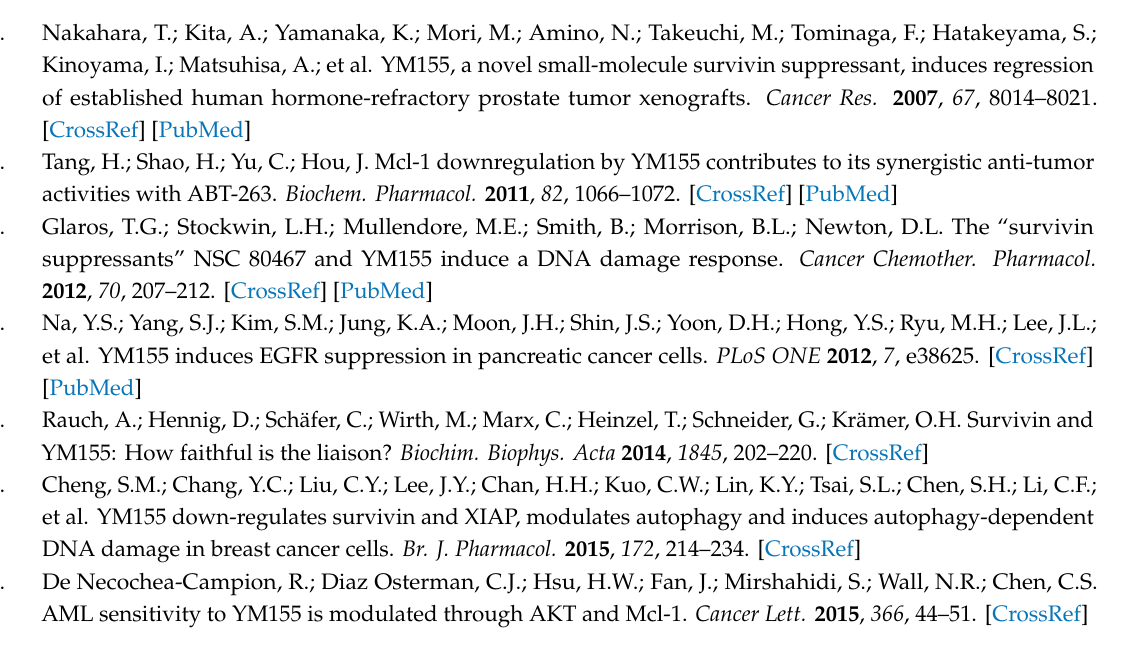
Figure S1: Representative photos of the project cell lines, Figure S2: Representative Western blots indicating cellular levels of p53 in UKF-NB-3 and YM155-adapted UKF-NB-3 sub-lines, Figure S3: Representative Western blots indicating cellular levels of survivin in UKF-NB-3 and YM155-adapted UKF-NB-3 sub-lines, Figure S4: Representative Western blots indicating cellular levels of survivin in UKF-NB-3 and its YM155-adapted UKF-NB-3 sub-lines 48h after transfection with non-targeting siRNA or siRNA directed against BIRC5 / survivin, Figure S5: Representative Western blots indicating cellular levels of ABCB1 and SLC35F2 in UKF-NB-3 and YM155-adapted UKF-NB-3 sub-lines, Figure S6: E ff ects of di ff erent siRNAs in UKF-NB-3 cells, Table S1: YM155 concentrations (nM) that reduce the viability of UKF-NB-3 or YM155-adapted UKF-NB-3 sub-lines by 50% (IC 50 ) or 90% (IC 90 ), Table S2: Drug concentrations that reduce the viability of UKF-NB-3 or YM155-adapted UKF-NB-3 sub-lines by 50% (IC 50